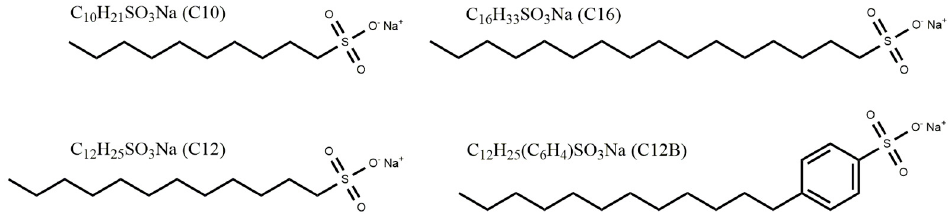
Figure 2. Chemical structures of sulfonate-based collectors.